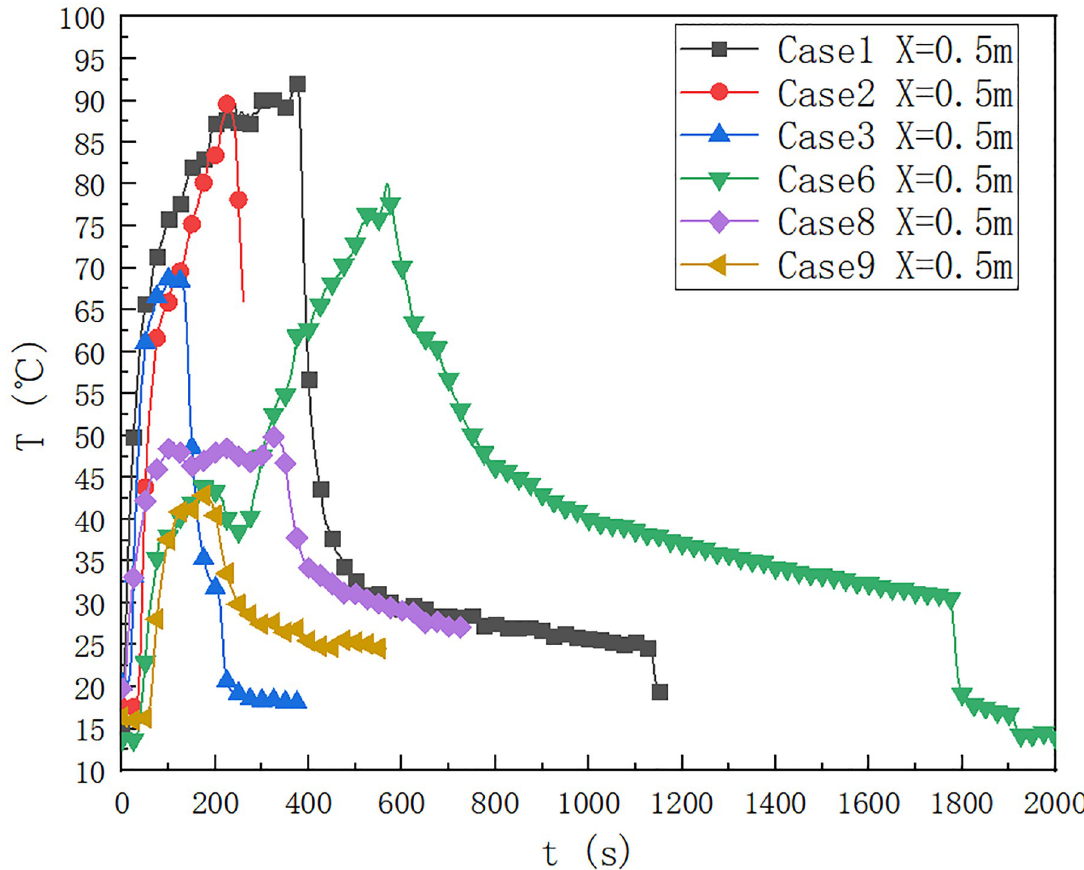
Fig 4. Temperature change below the ceiling of the cable compartment in the utility tunnel at 1, 2, 3, 6, 8 and 9 at a distance of 0.5 m from the fire source.